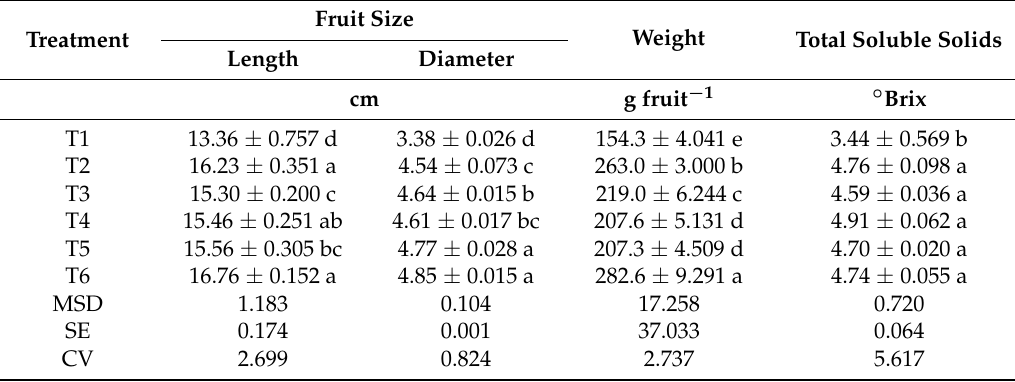
Table 3. Diameter, length, weight, and total soluble solids of cucumber fruits in shaded house conditions, with foliar applications of algae